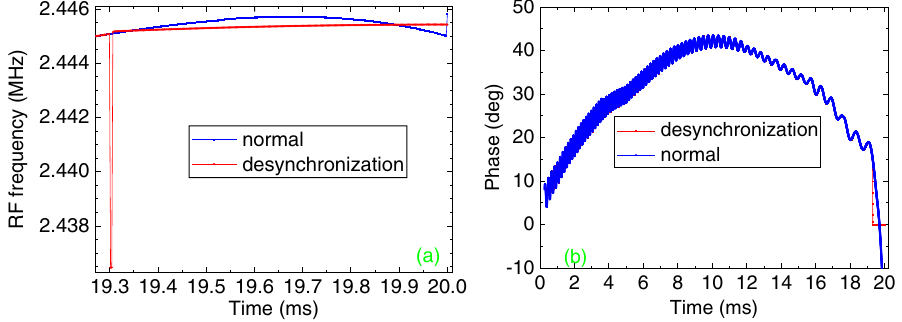
FIG. 12. (a) The rf frequency pattern for the normal mode (blue) and the desynchronization mode obtained from the simulation (red). (b) The simulated bunch phase during the CSNS/RCS acceleration cycle for the normal mode (blue) and the desynchronization mode